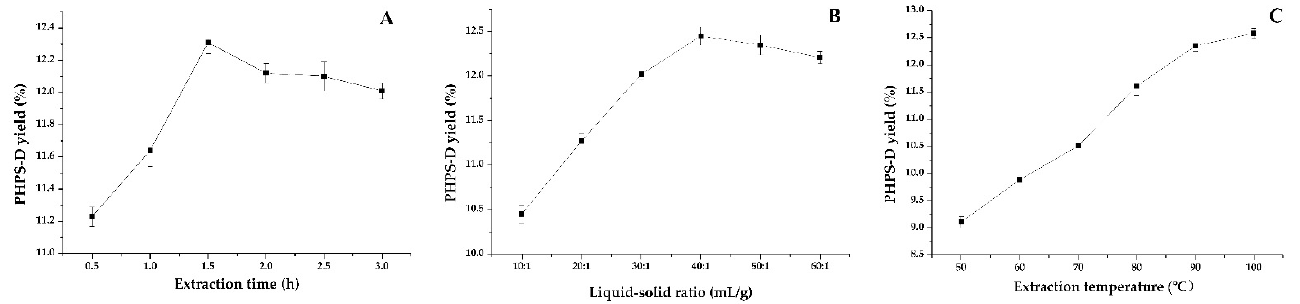
Figure 2. Effect of various single factors on the extraction yield of PHPS-D: ( A ) effect of extraction time on PHPS-D yield; ( B ) effect of liquid to solid ratio on PHPS-D yield; ( C ) effect of extraction temperature on PHPS-D yield.